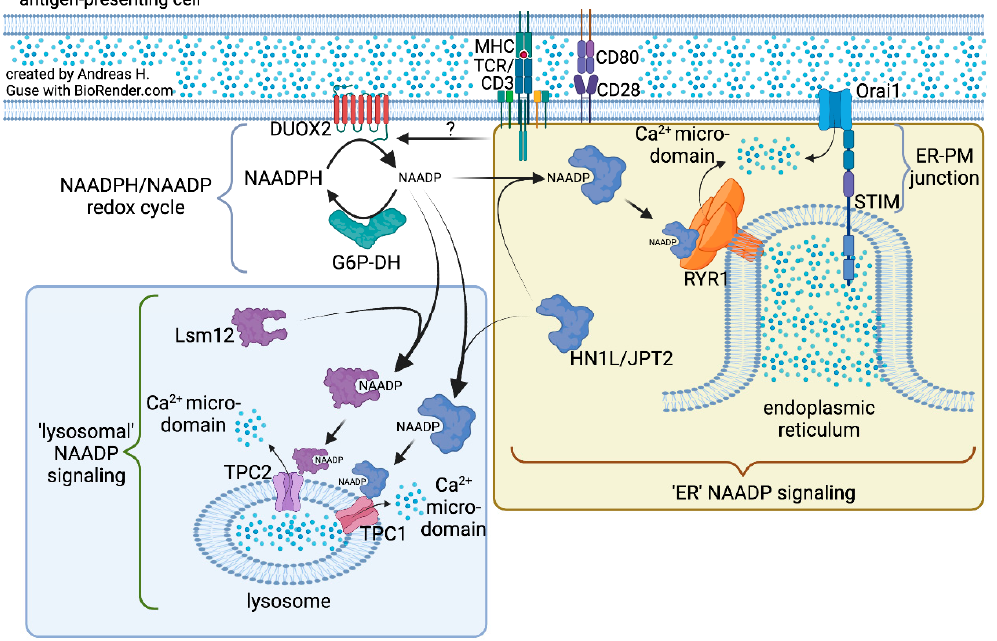
Figure 2. Ca 2+ mobilization by NAADP mediated by NAADP receptors/binding proteins linking to different organelles and ion channels.